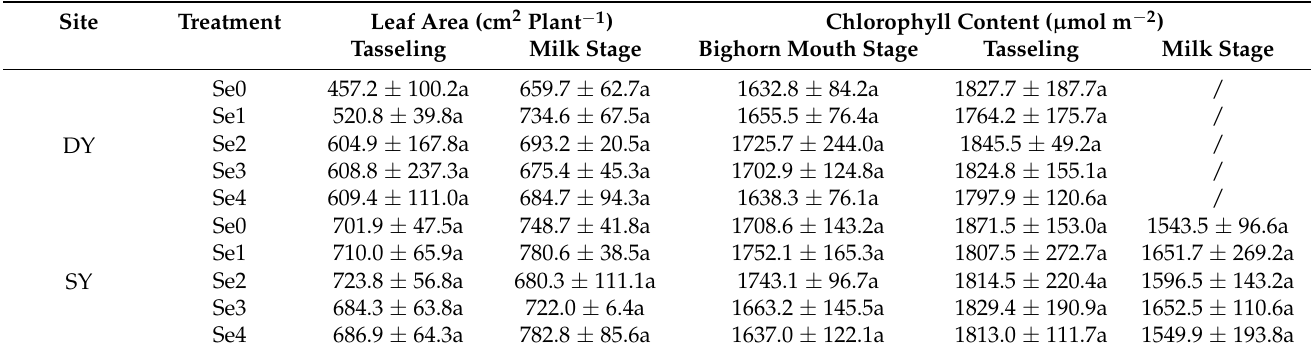
Table 3. Effects of Se fertilizer application on leaf area and chlorophyll content of maize at locations DY and